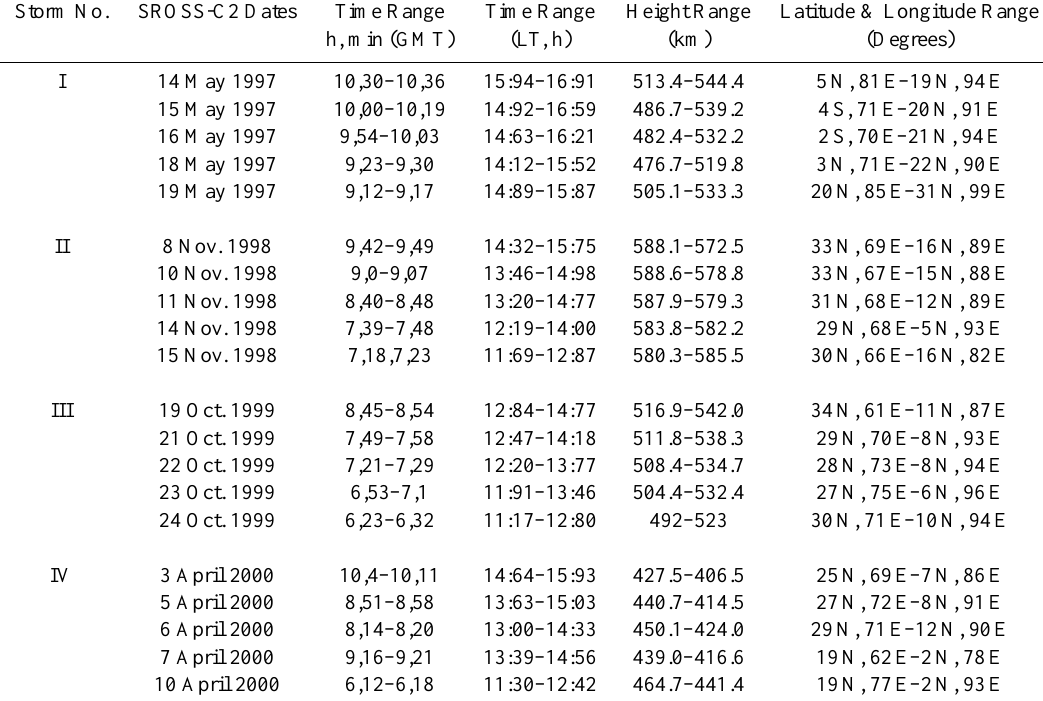
Table 2. Details of the daytime SROSS-C2 observations during the period of four magnetic storm events. Storm No. SROSS-C2 Dates Time Range Time Range Height Range Latitude & Longitude Range h, min (GMT) (LT, h) (km)